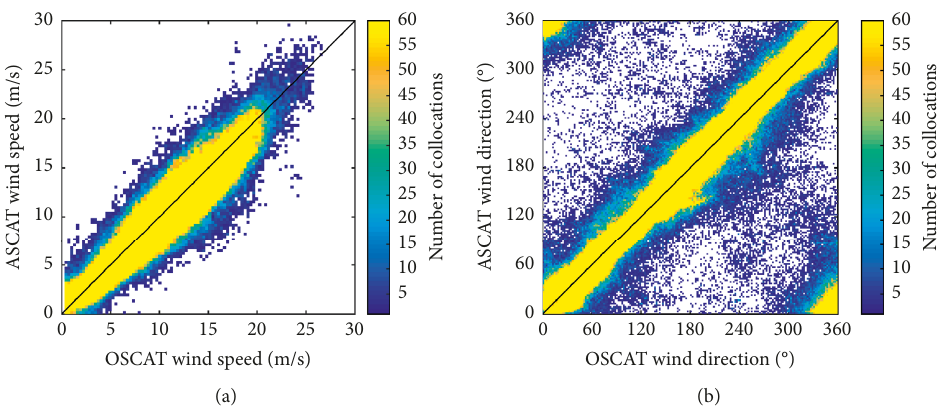
Figure 7: Scatterplots for wind speed and direction of the comparisons between OSCAT and ASCAT.